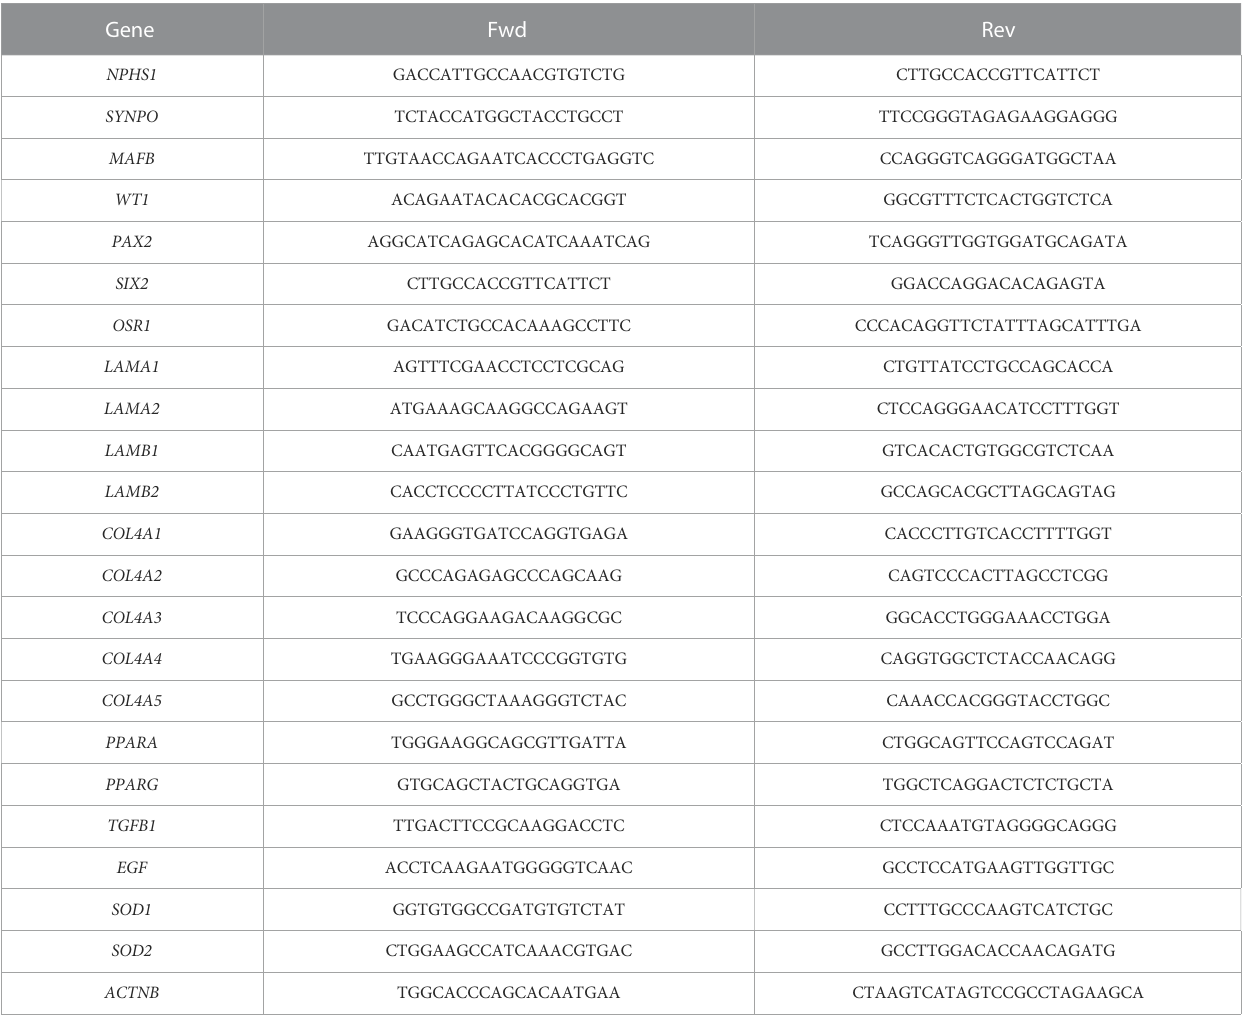
TABLE 2 Primers used for Q-PCR